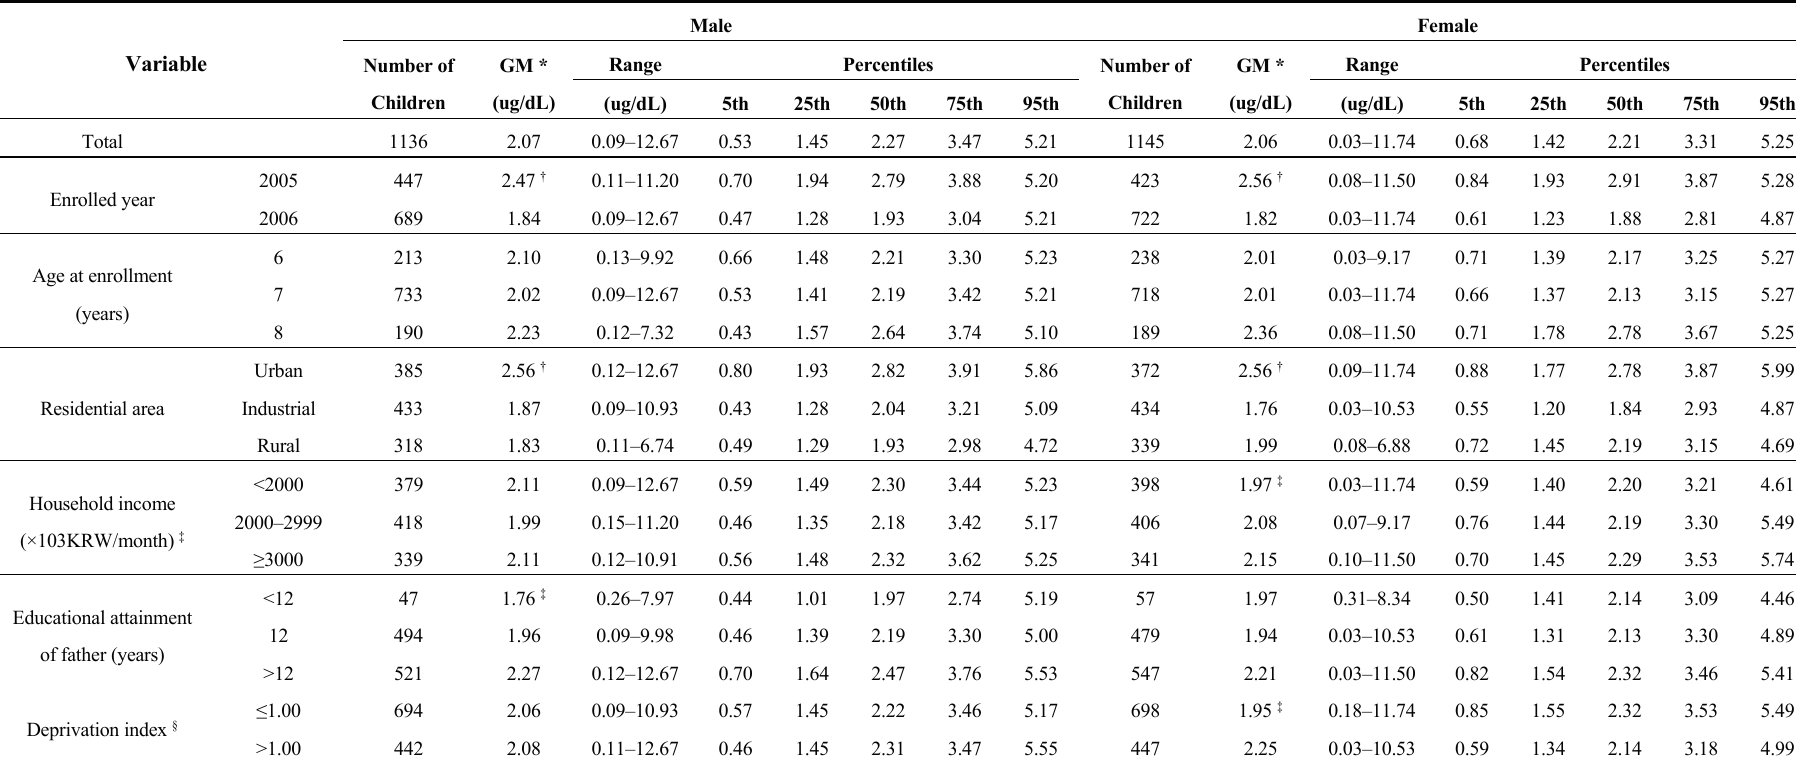
Table 2. Blood mercury distributions at enrollment according to basic characteristics and socioeconomic positions of 2281 children, CHEER, 2005–2006, Korea.